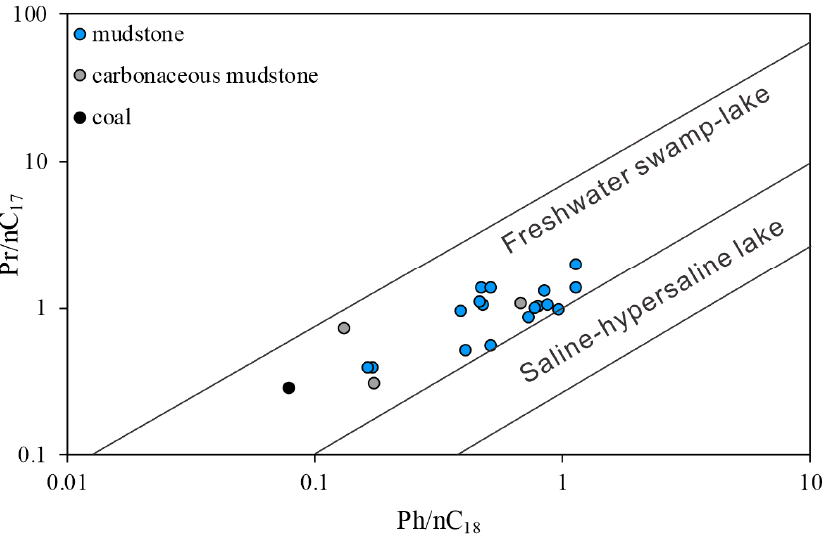
Figure 6. Cross ‐ plot of Pr/nC 17 vs. Ph/nC 18 for coal ‐ measure source rocks (after Duan et al., 2006 Figure 6. Cross-plot of Pr/nC 17 vs. Ph/nC 18 for coal-measure source rocks (after Duan et al., 2006 [36]). [36]).